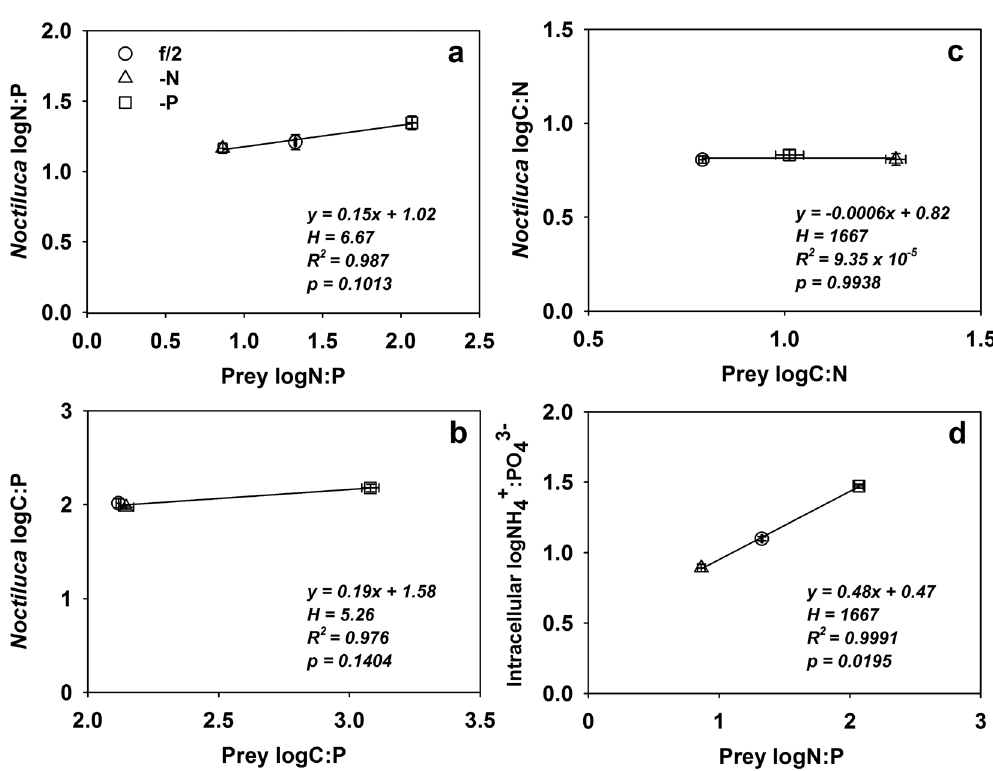
Figure 2. Regressions of log-normalized resource and consumer elemental ratios for Noctiluca scintillans : ( a ) N:P; ( b ) C:P; ( c ) C:N; ( d ) intracellular NH 4 + : PO 43 − . 1/H is the slope of the regression between log-normalized resource and consumer elemental ratios. H = 1/slope. Error bars = ± 1 SD, n =